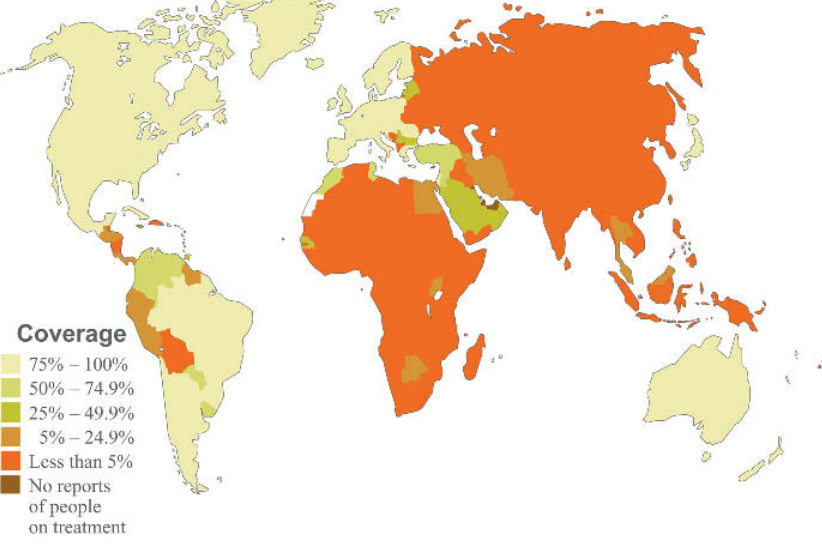
Figure 1. Estimated Percentage of Adults in Need of Antiretroviral Treatment Who Are Receiving It, as of March of 2004 (This graphic is based on an image by the World Health Organization, available at